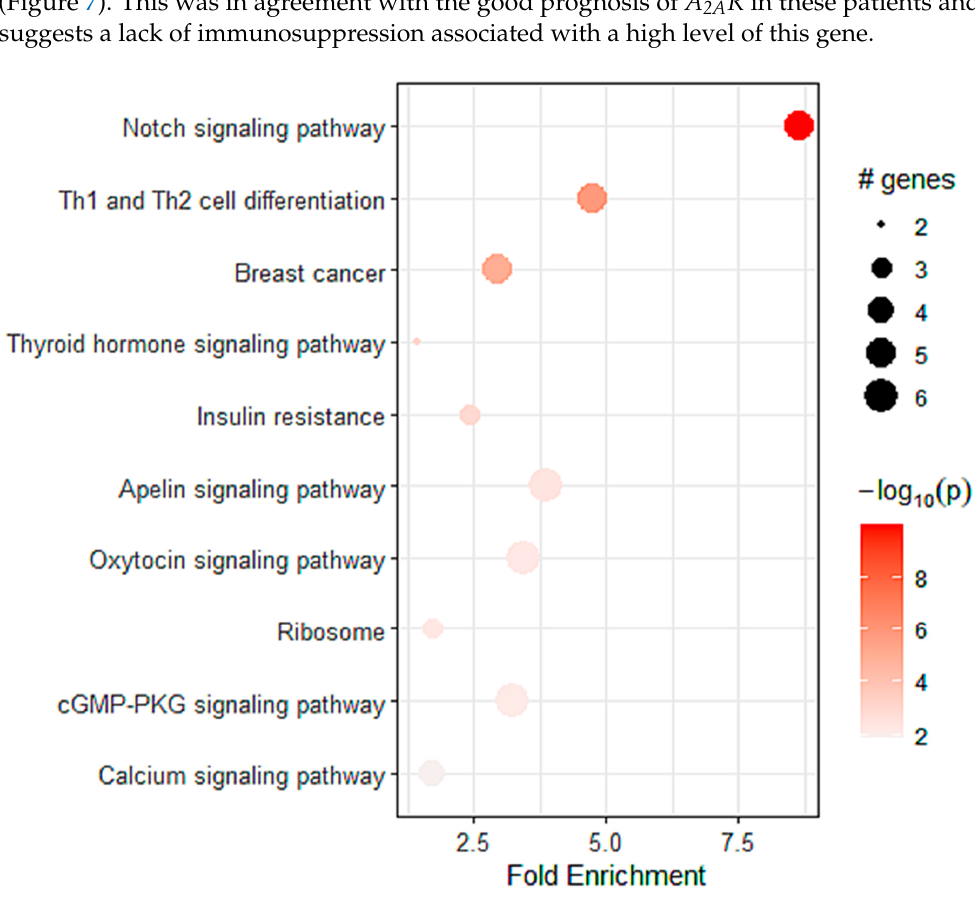
Figure 7. The top pathways for strong A 2A R expression obtained by KEGG enrichment in TCGA astrocytoma patients. Table 6. The top pathways for strong A 2A R expression obtained by Hallmark enrichment in TCGA astrocytoma patients.